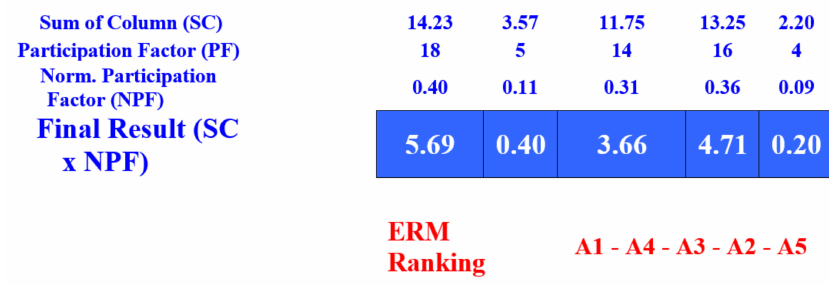
Figure A6. ERM ranking of alternatives.